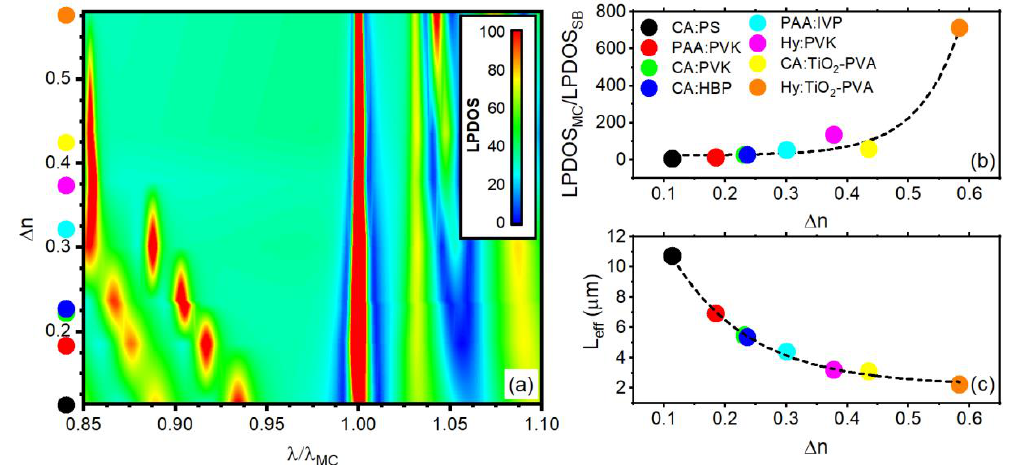
Figure 5. Relation between the local density of photonic states (LPDOS) and ∆ n. ( a ) Contour plot of the LPDOS as a function of ∆ n and normalized wavelength ( λ / λ MC ). ( b ) Ratio between the LPDOS at the cavity mode and at the PBG and ( c ) MC e ff ective length versus ∆ n.